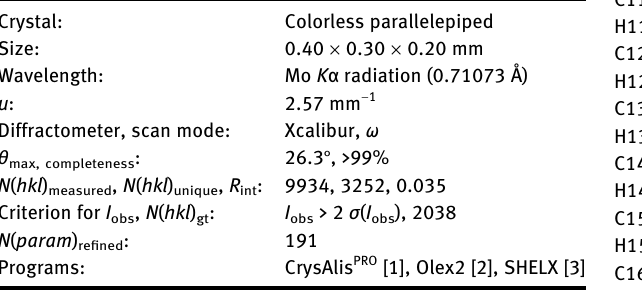
Table  : Data collection and handling.